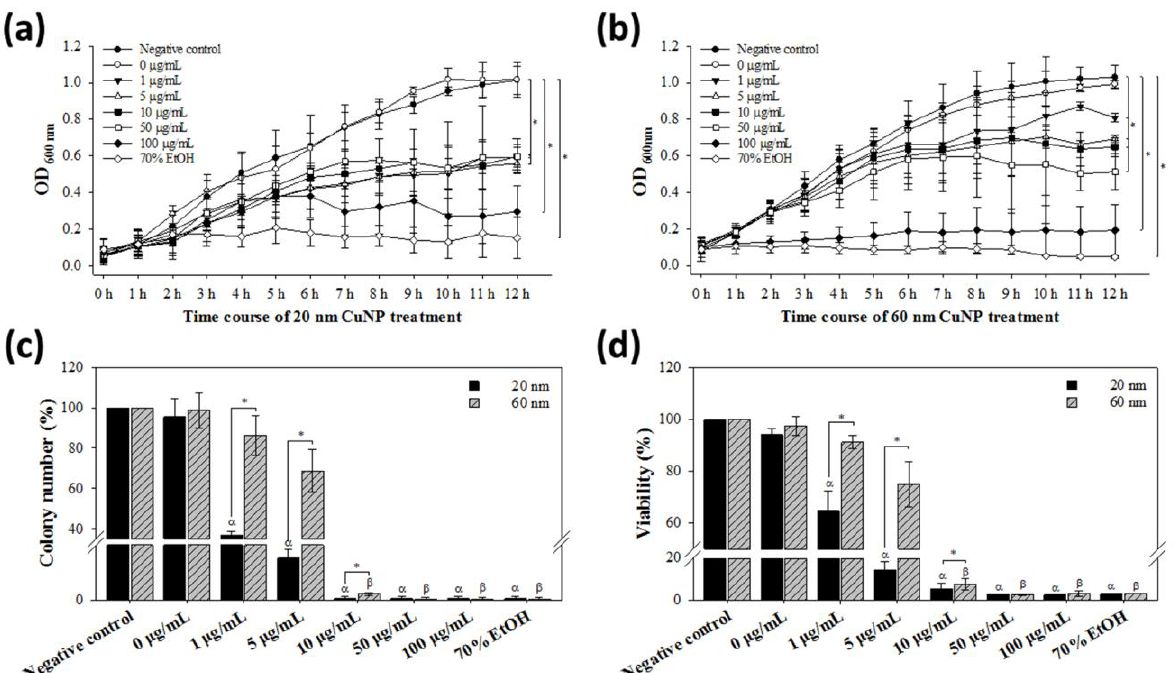
Figure 1. Bactericidal activities of CuNPs. E. coli were treated with different concentrations of CuNPs of 20 nm or 60 nm size. Bacteria treated with PBS or 70% alcohol were used as the negative and positive controls, respectively. ( a , b ) Determination of E. coli growth by optical density measurement. Cell growth curves from 0 to 12 h were analyzed with absorbance at 600 nm wavelength. Statistical calculation after treatment for 12 h was analyzed. ( c ) The percentage of colony formation of E. coli recovered after treatment with CuNPs for 24 h. ( d ) Bacterial viability analysis with PrestoBlue assay after treatment with CuNPs for 24 h. Bioactivities were determined at the emitting fluorescence of 590 nm. In both ( c , d ), one hundred percent value corresponds to the number in the negative control. Data are presented as mean ± SD from three independent experiments performed in triplicate for each treatment group. Statistical comparisons were performed by Student’s t -test; α and β indicate p < 0.05 for 20 and 60 nm CuNP treatments relative to the negative control, respectively, and * indicates p < 0.05 for comparisons between 20 and 60 nm of CuNPs in ( c , d